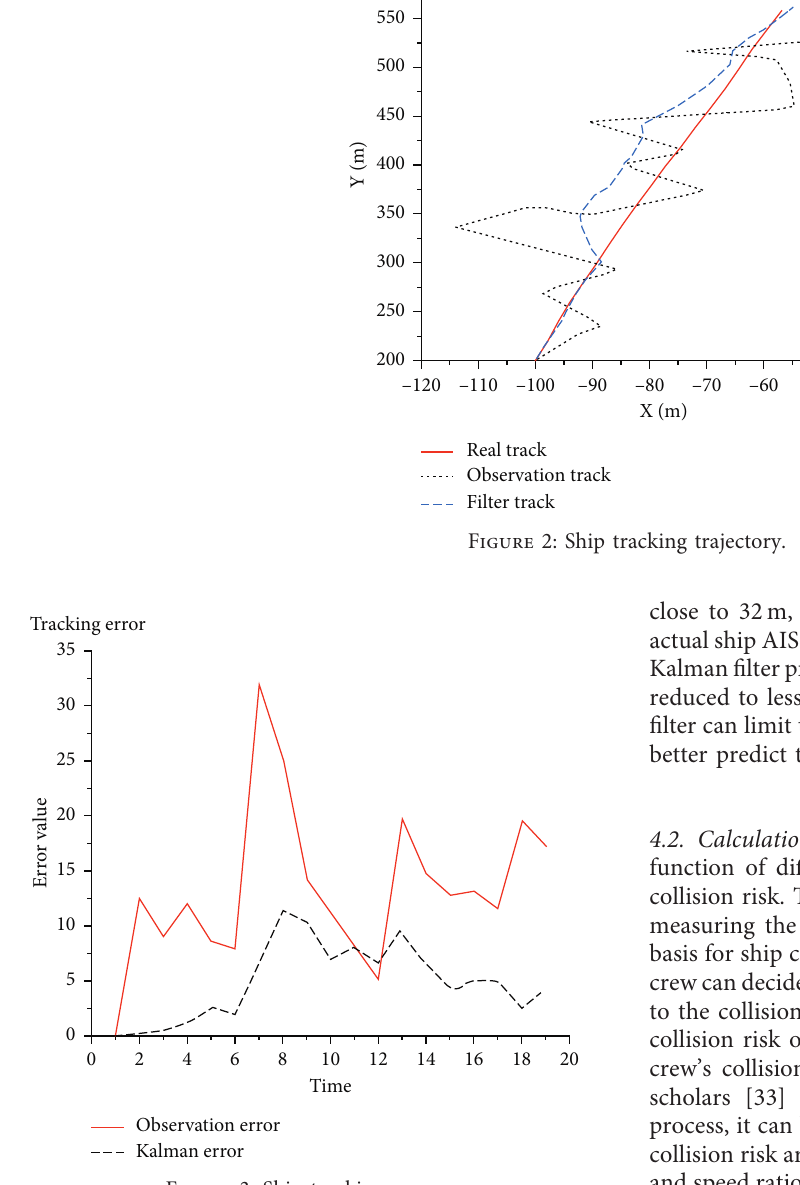
Figure 3: Ship tracking